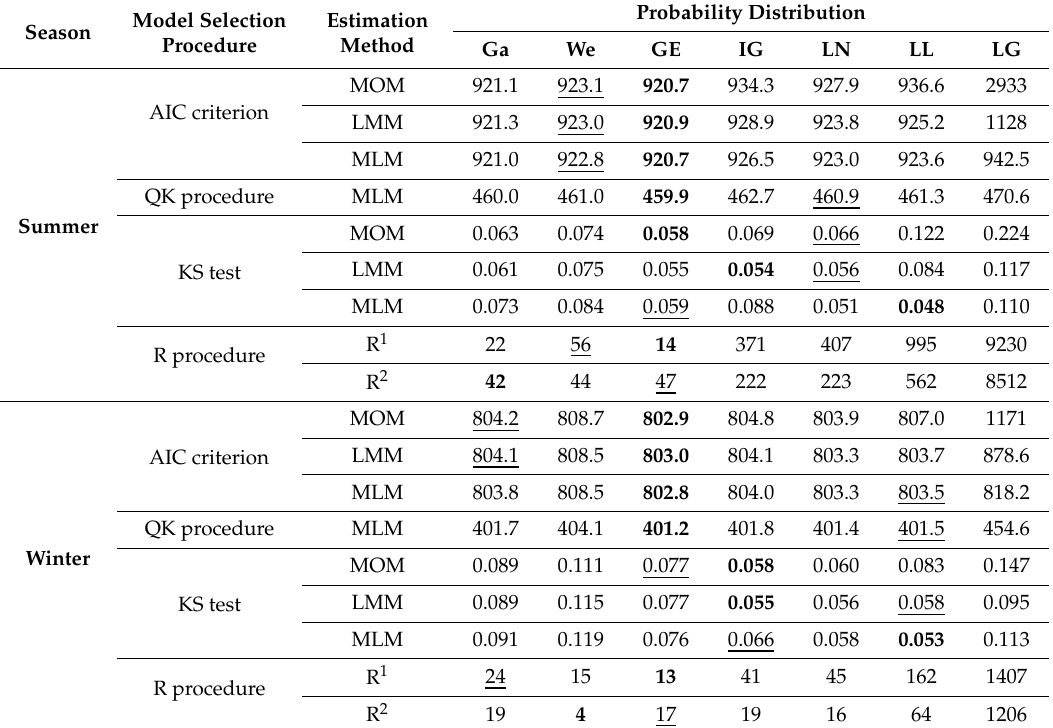
Table 3. The results of the model selection procedures for the two-parameter distributions being fitted to the seasonal maximum flows in 1951–2016 at the Prosz ó wki gauging